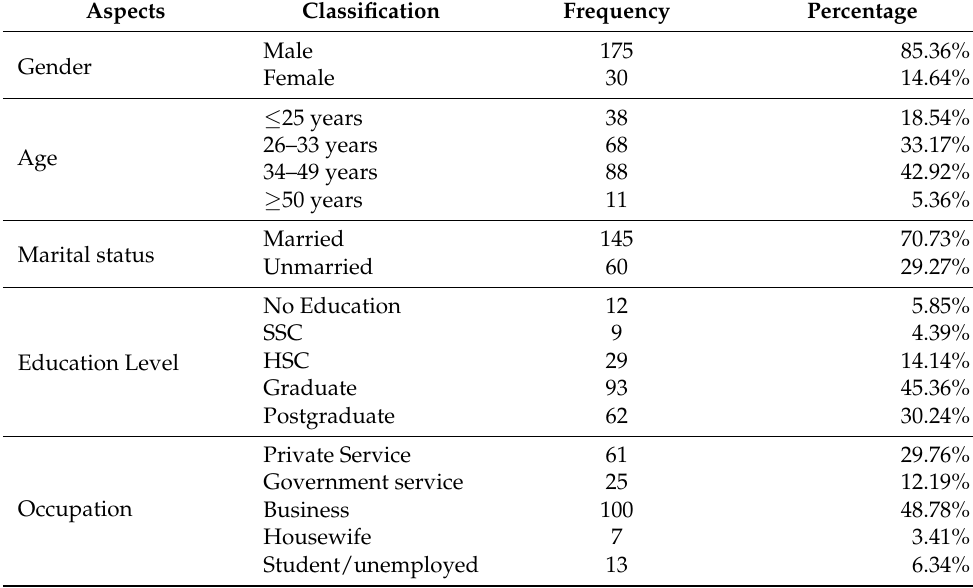
Table 1. Demographic profile of the respondents ( n =